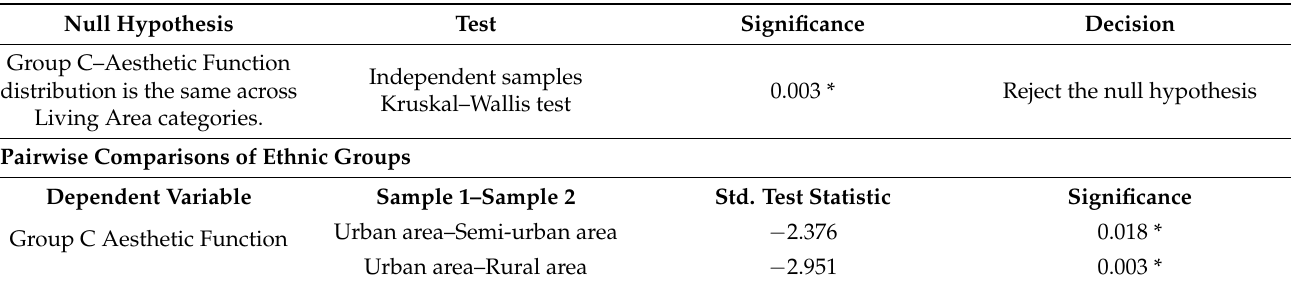
Table 9. The difference in responses to aesthetic function between living area groups.